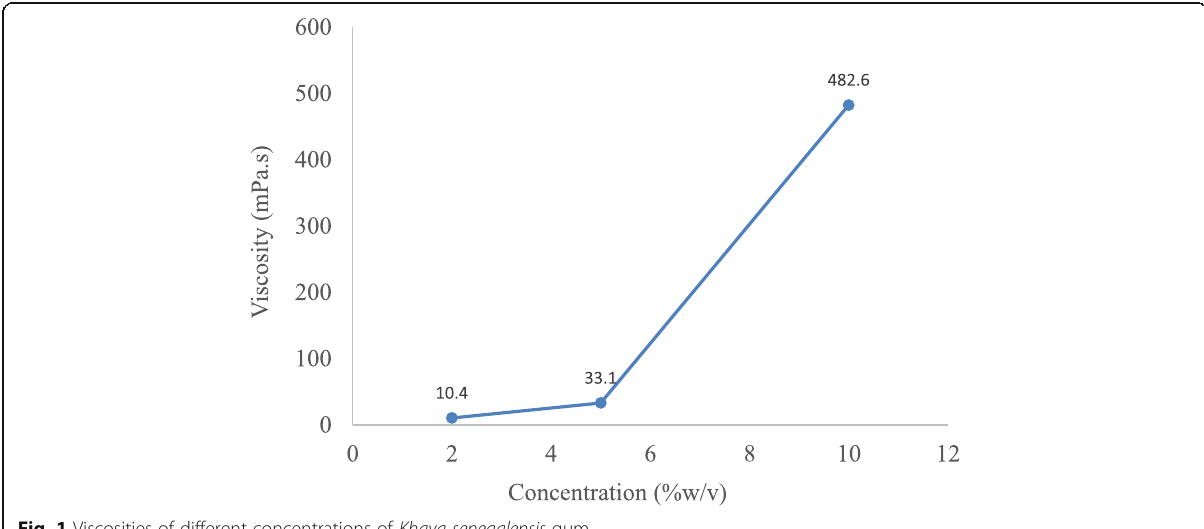
Fig. 1 Viscosities of different concentrations of Khaya senegalensis gum